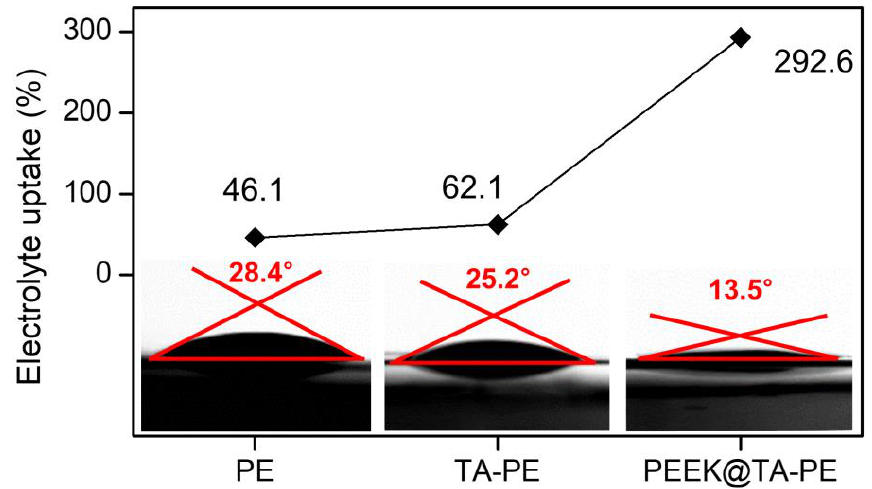
Figure 5. Electrolyte uptake and contact angle measurement results of the PE, TA-PE, and PEEK@TA-PE separators.